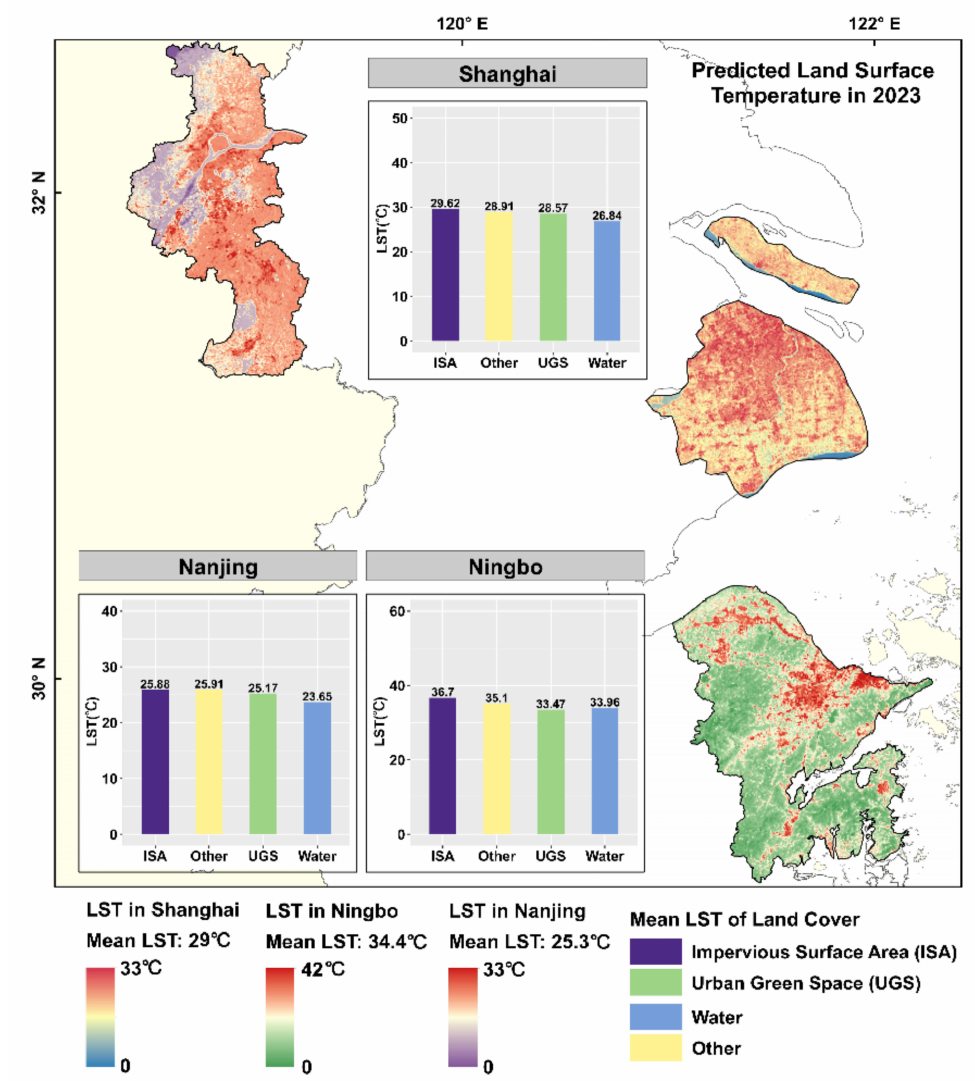
Figure 15. Predicted LST and the average LST corresponding to each LSC in 2023 across Shang- hai, Ningbo and Nanjing using the BP neural network model under the natural scenario of the LCS